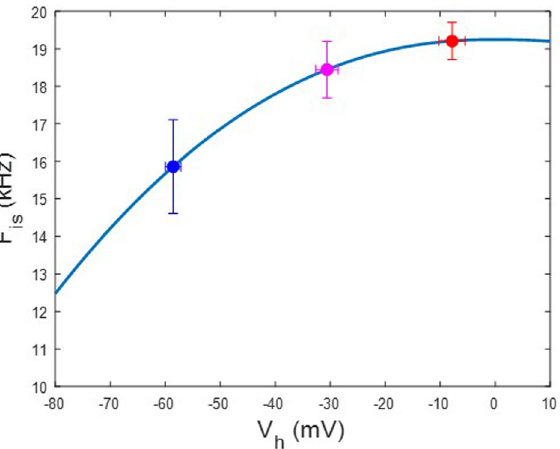
Figure 6. F is for complex NLC patch data for patches recategorized into 3 V h groups. Error bars are SE. Note that as V h is more negative, F is increases nonlinearly. This shows that V h influences the frequency responses of real and imaginary components of complex